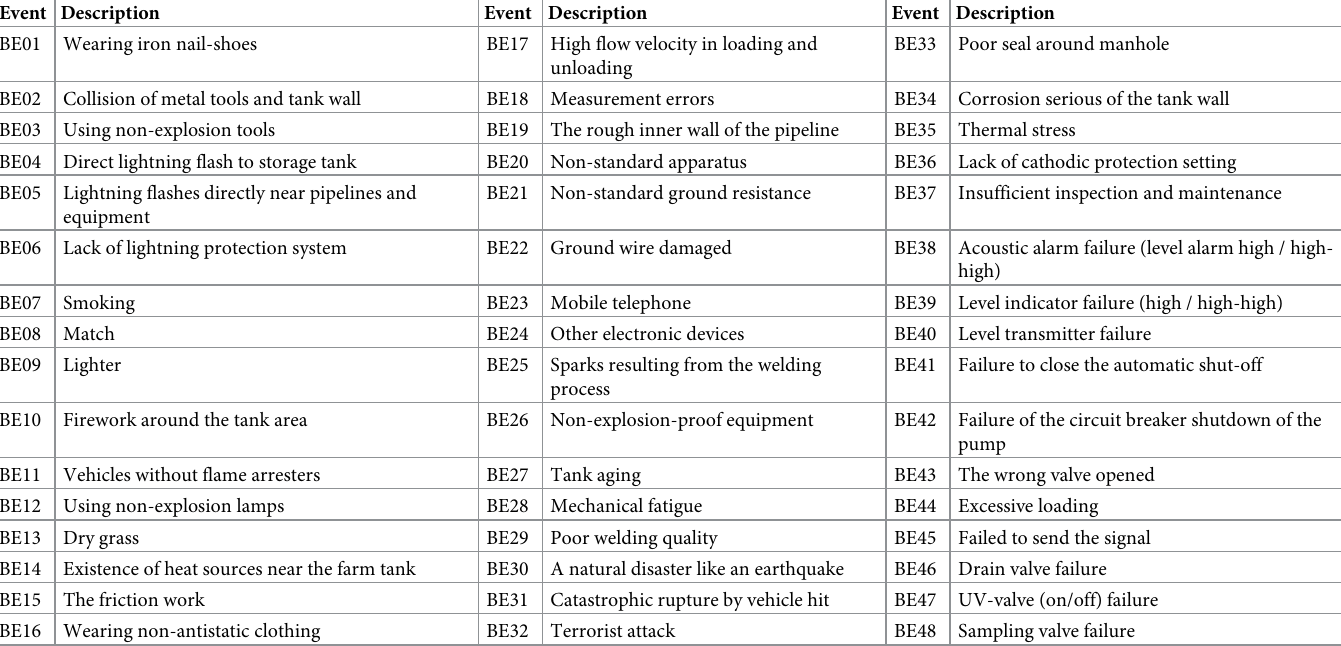
Table 2. Basic events in the proposed fault tree and descriptions.